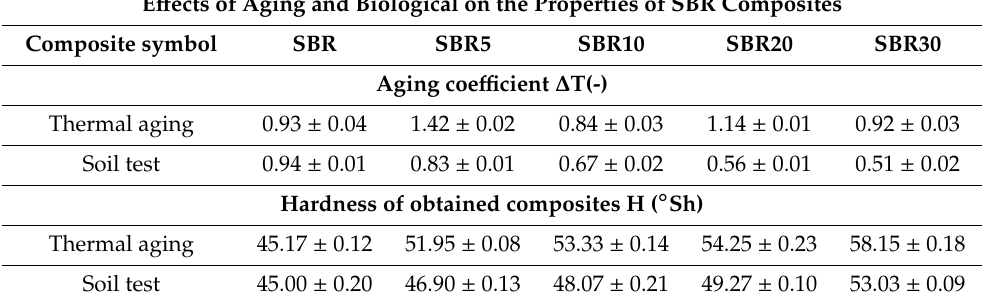
Table 6. Mechanical properties after